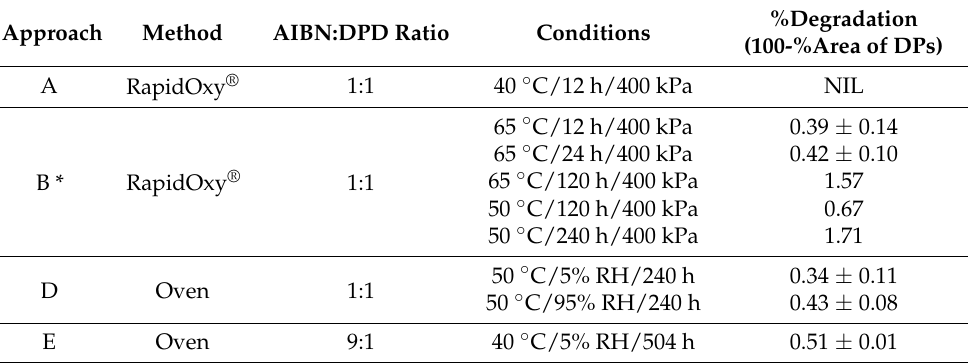
Table 1. Experimental results indicating degradation with approaches containing AIBN:DPD (in replicates N =